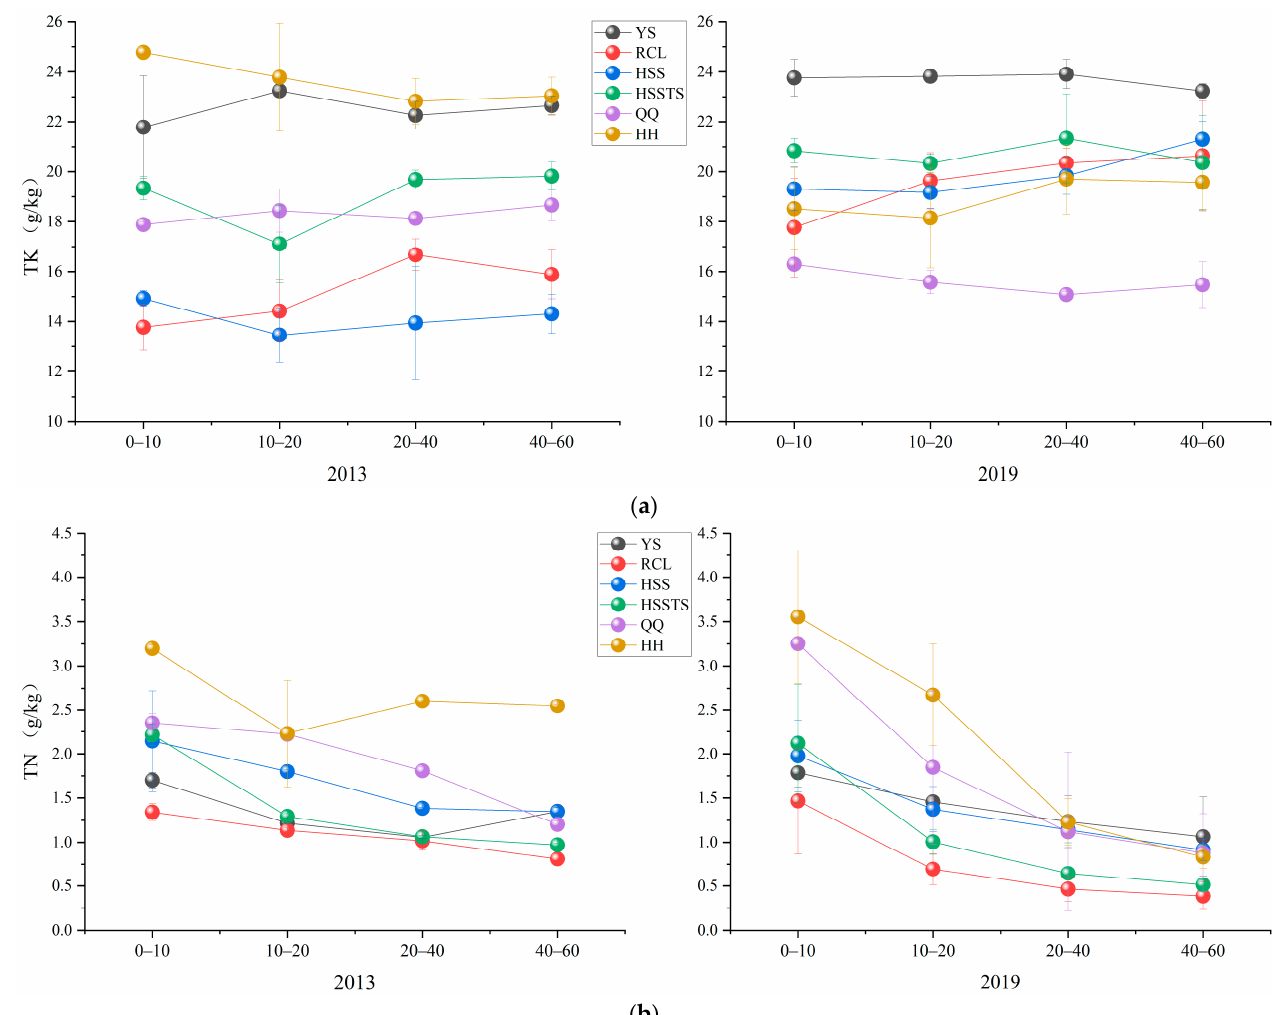
Figure 5. Soil available nutrient content of different forest communities at four soil depths in both 2013 and 2019; ( a ) soil ammonium nitrogen, ( b ) soil nitrate nitrogen, ( c ) soil available phosphorus, ( d ) soil available potassium.